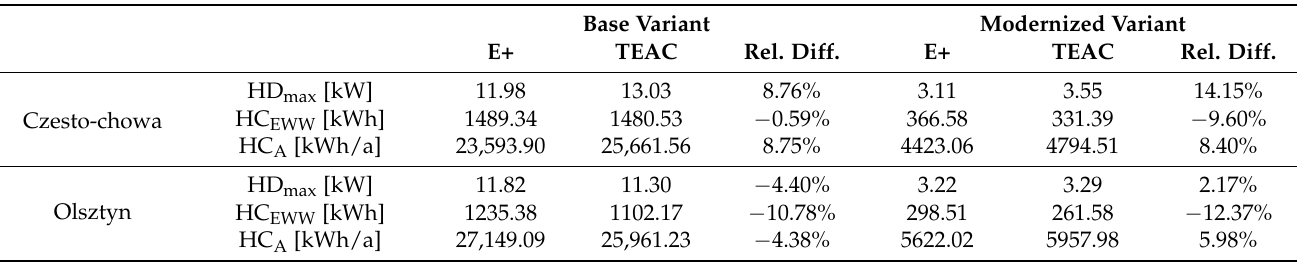
Table 1. Comparison of the results obtained by means of the Energy Plus (E+) and the TEAC software. Base Variant